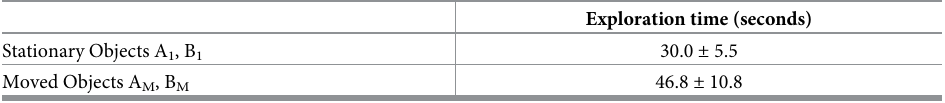
Table 5. Total exploration times of previously viewed objects that were either stationary or moved during the 4-object test (F(1,25) = 7.805, p < 0.01; ε = 0.238).